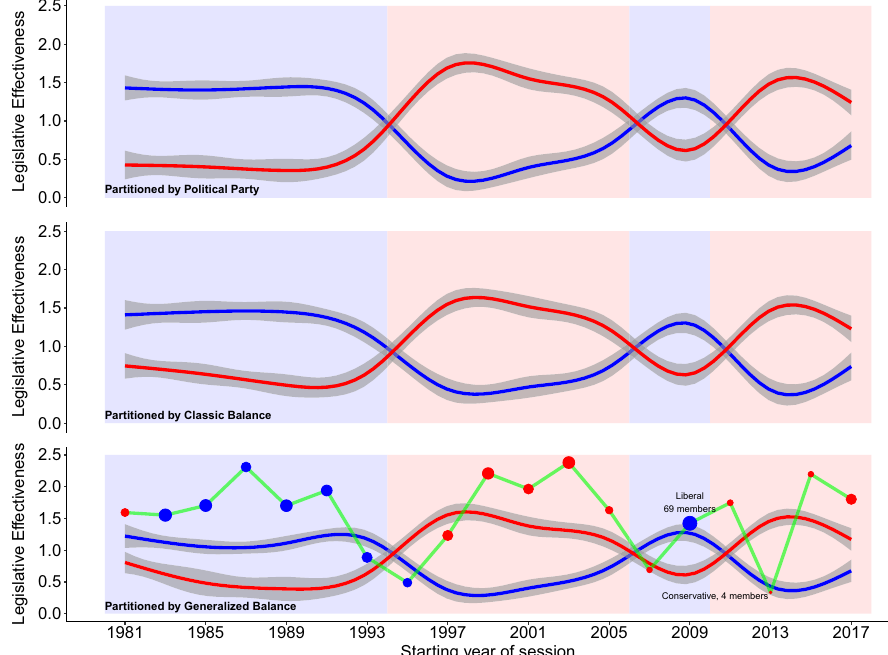
Figure 4. Mean of coalition members’ legislative effectiveness in the US House of Representatives. Blue (red) lines indicate the mean legislative effectiveness of Democrats (Republicans) in the top panel and that of the dominant liberal (conservative) coalitions in the center and bottom panels. In the bottom panel, the green line indicates the mean ideological effectiveness of members of the smallest coalition, while the size and color of the dot indicates the size and mean ideology of this coalition. Background shading indicates whether Democrats (blue) or Republicans (red) held a majority in the chamber during the respective